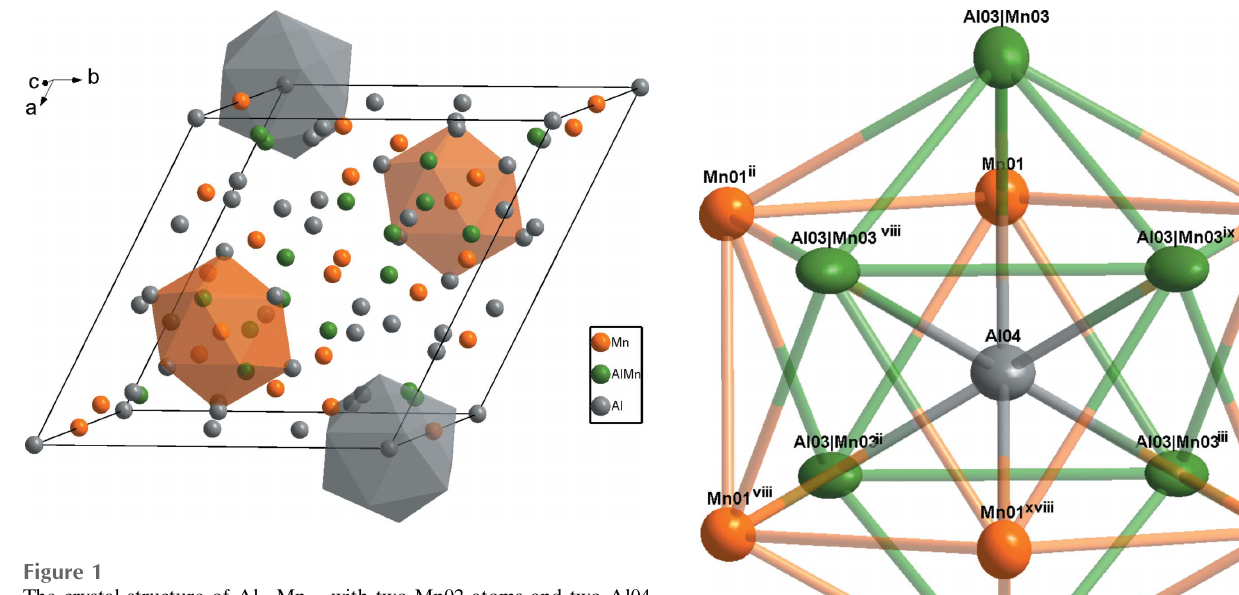
, x (cid:3) 1 , (cid:3) z + 2 ; 3 3 3